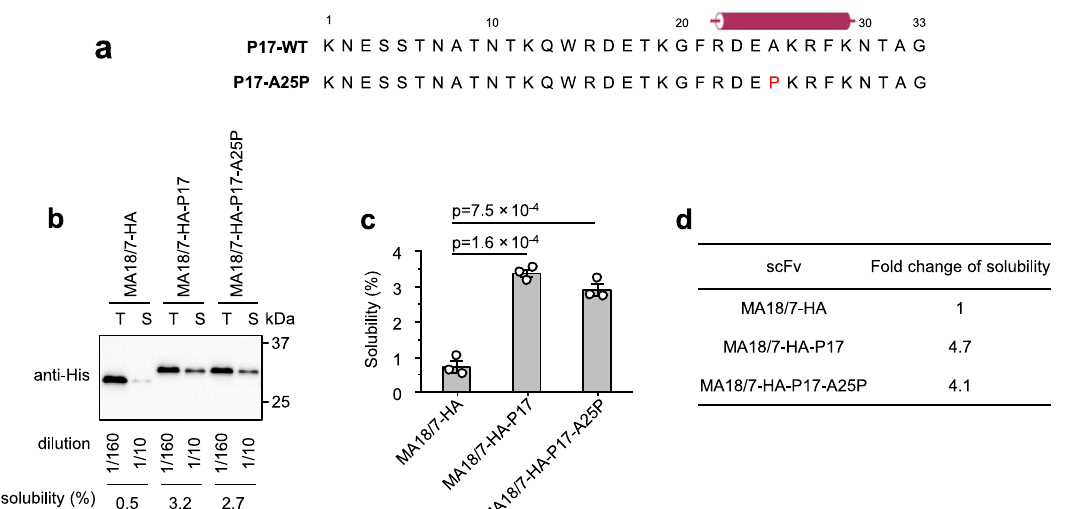
Fig. 5 | A putative α -helix in the P17 tag was not required for solubility enhancement. a Amino acid sequences of wild-type (wt) P17 tag (P17-WT) and it's mutant (P17-A25P) with alanine 25 substituted by proline. The predicted α -helix formed by P17 tag residues 22 – 29 is depicted as a cylinder. Proline 25 of P17-A25P mutantisshowninred. b Representativewesternblottodeterminethesolubilityof MA18/7-scFv-HAproteinanditstwoderivativeswithC-terminallyfusedP17-WTand